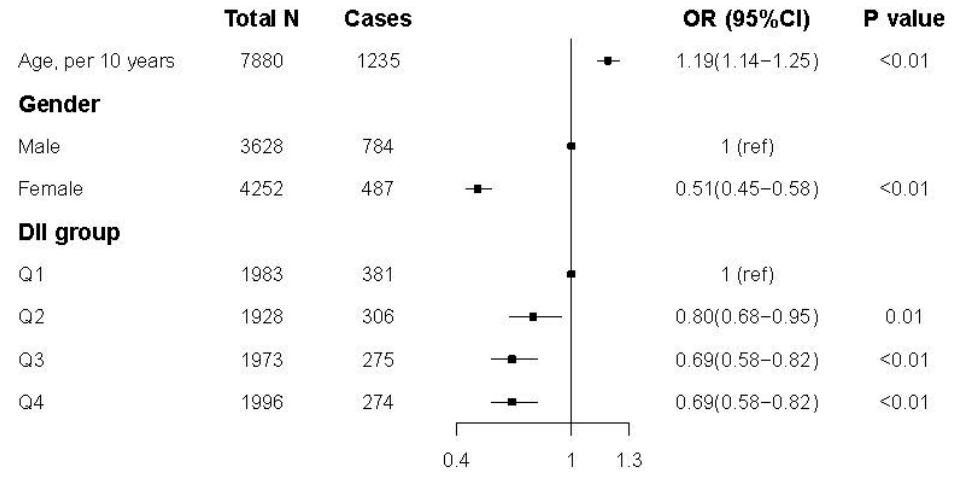
Figure 2. Odds ratios (ORs) and 95% confidence intervals for hyperuricemia in CHNS. The results of the correlation between the DII score and the risk of hyperuricemia (stratified by gender) were shown in Table 3. Both men and women with lower DII